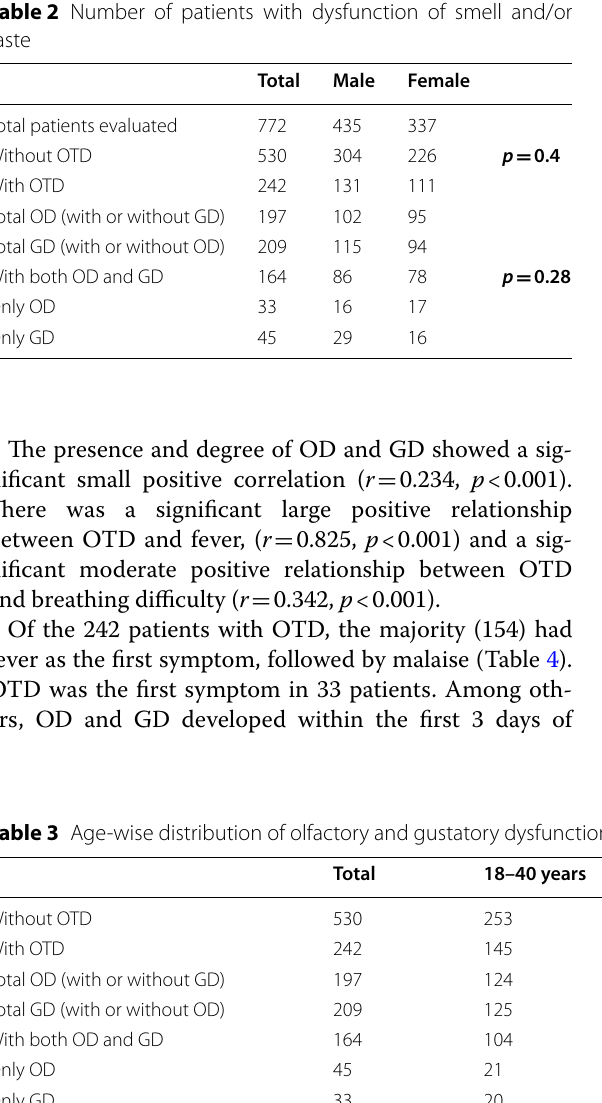
Table 2 Number of patients with dysfunction of smell and/or